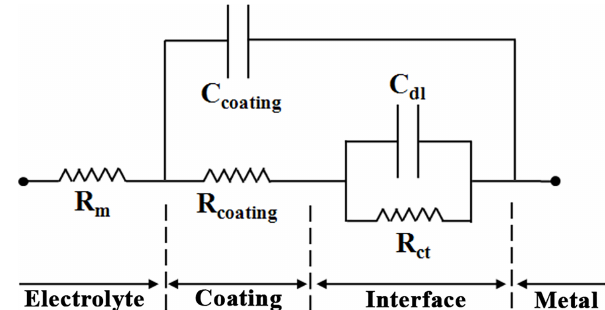
Figure 9. Equivalent circuit of a metal coated with an organic poly- mer in contact with an